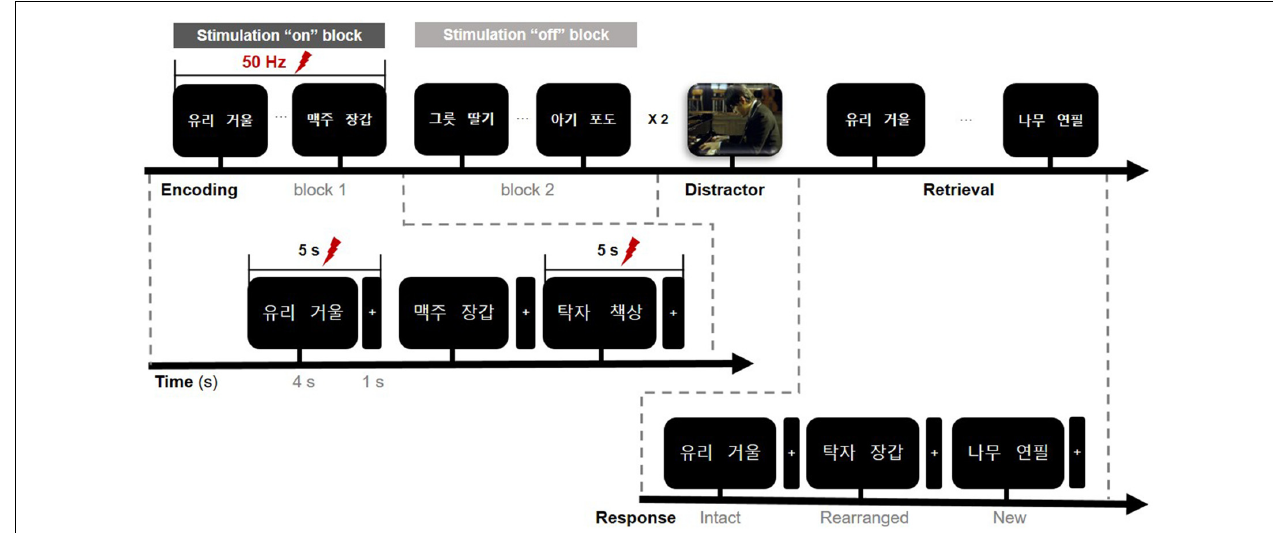
FIGURE 2 | Timeline of the memory paradigm. The whole task consisted of three study periods: encoding, rest (distractor), and retrieval. Stimulation was delivered on-and-off at 50 Hz for 5 s during the encoding phase only and was randomly assigned to one of the two blocks in a single session. Lightning bolts denote periods of stimulation. In the encoding phase, the first word pair on the screen denotes “glass” (left) and “mirror” (right).